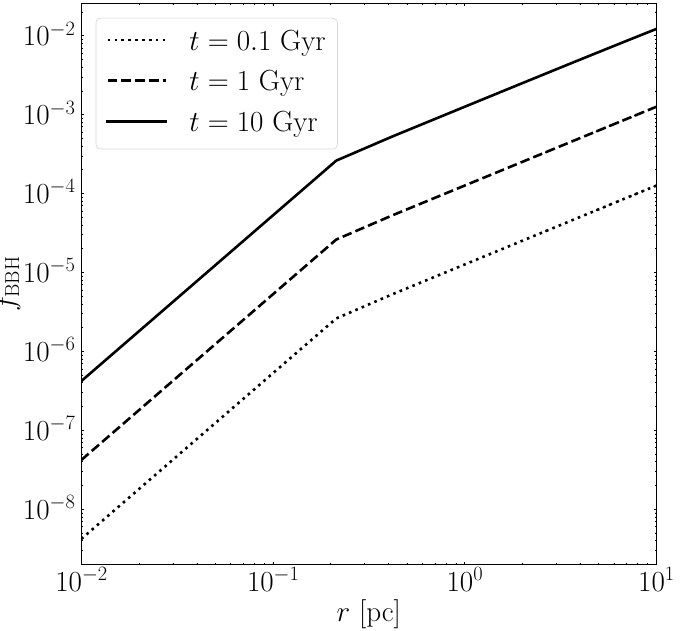
Figure 8. Fraction of binary black holes as a function of the distance to the Galactic Centre after an evolutionary time of 0.1 Gyr (dotted line), 1 Gyr (dashed line), and 10 Gyr (straight